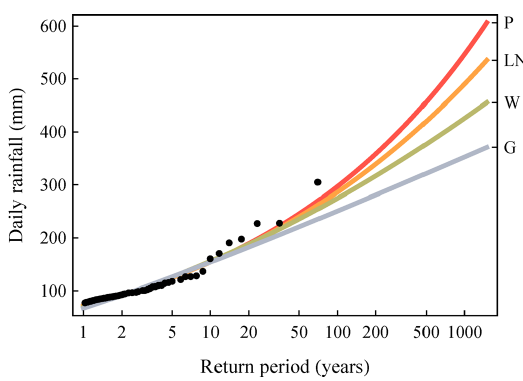
Fig. 1. Four different distribution tails fitted to an empirical tail (P, LN, W and G stands for the Pareto, the Lognormal, the Weibull and the Gamma distribution). A wrong choice may lead to severely underestimated or overestimated rainfall for large return